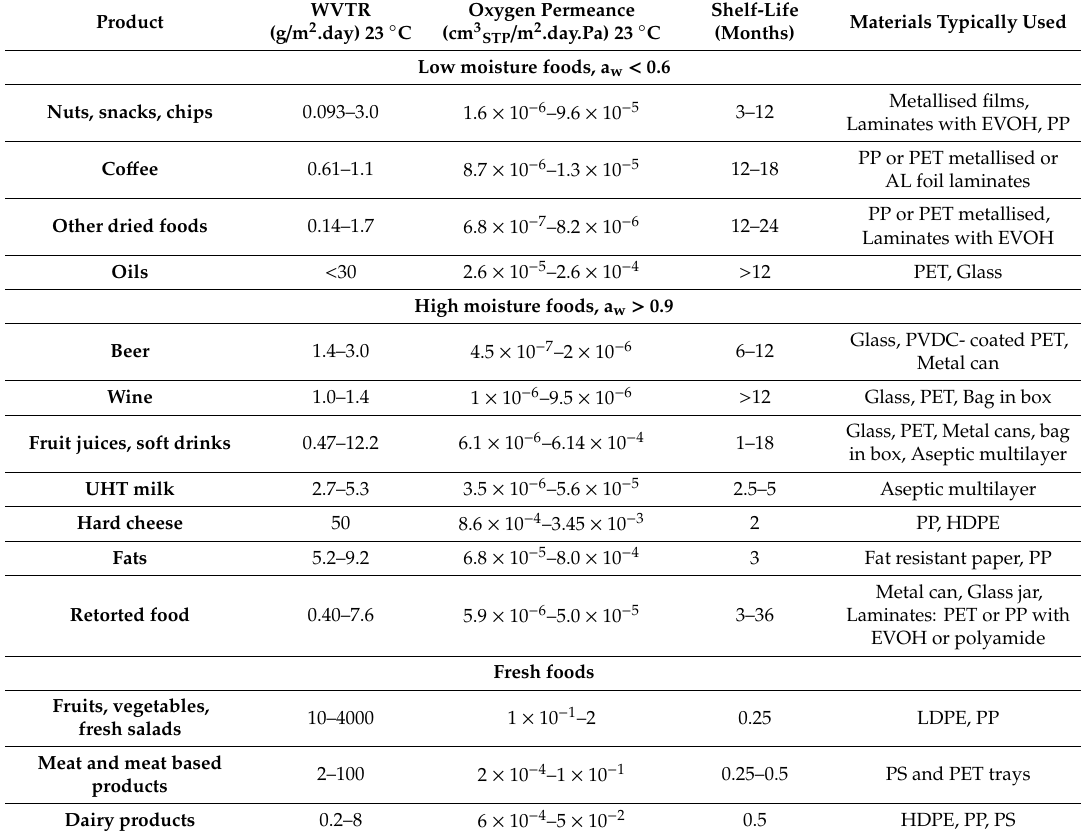
Table 1. Barrier properties requirements for specific food products [25] and typical materials